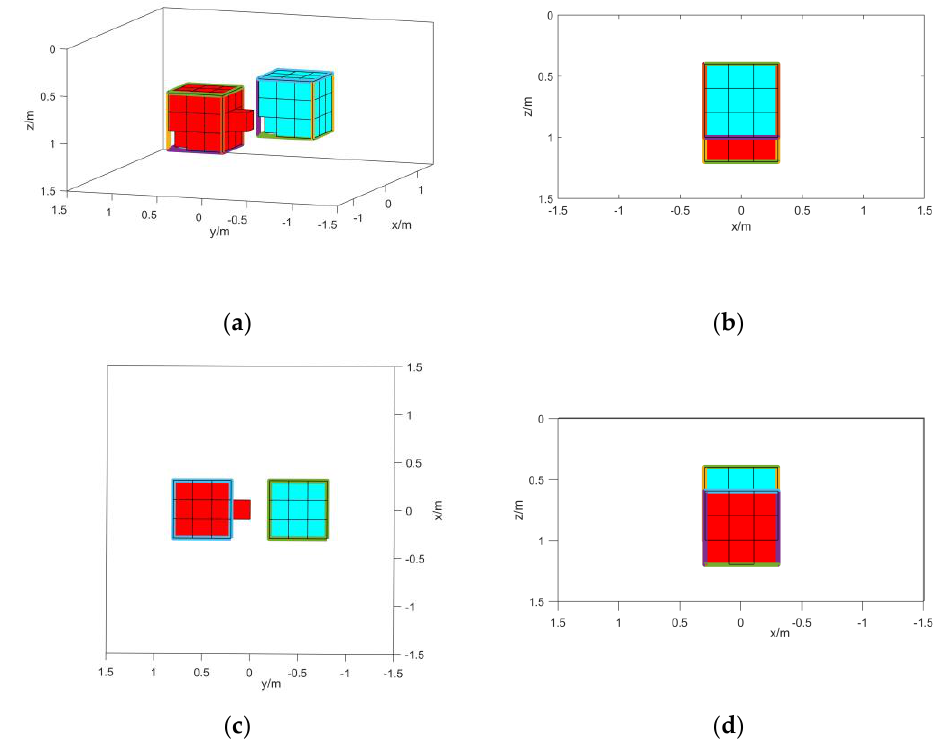
Figure 6. ( a ) Method 1 inversion results; ( b ) right-side view of method 1 inversion results; ( c ) top view of method 1 inversion results; ( d ) left-side view of method 1 inversion results. Table 4. Root mean square error between inversion results and measured data under different